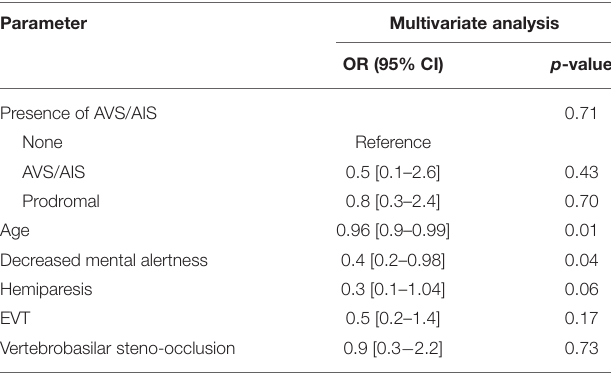
TABLE 6 | Clinical predictors of a good outcome in patients with major posterior circulation stroke.